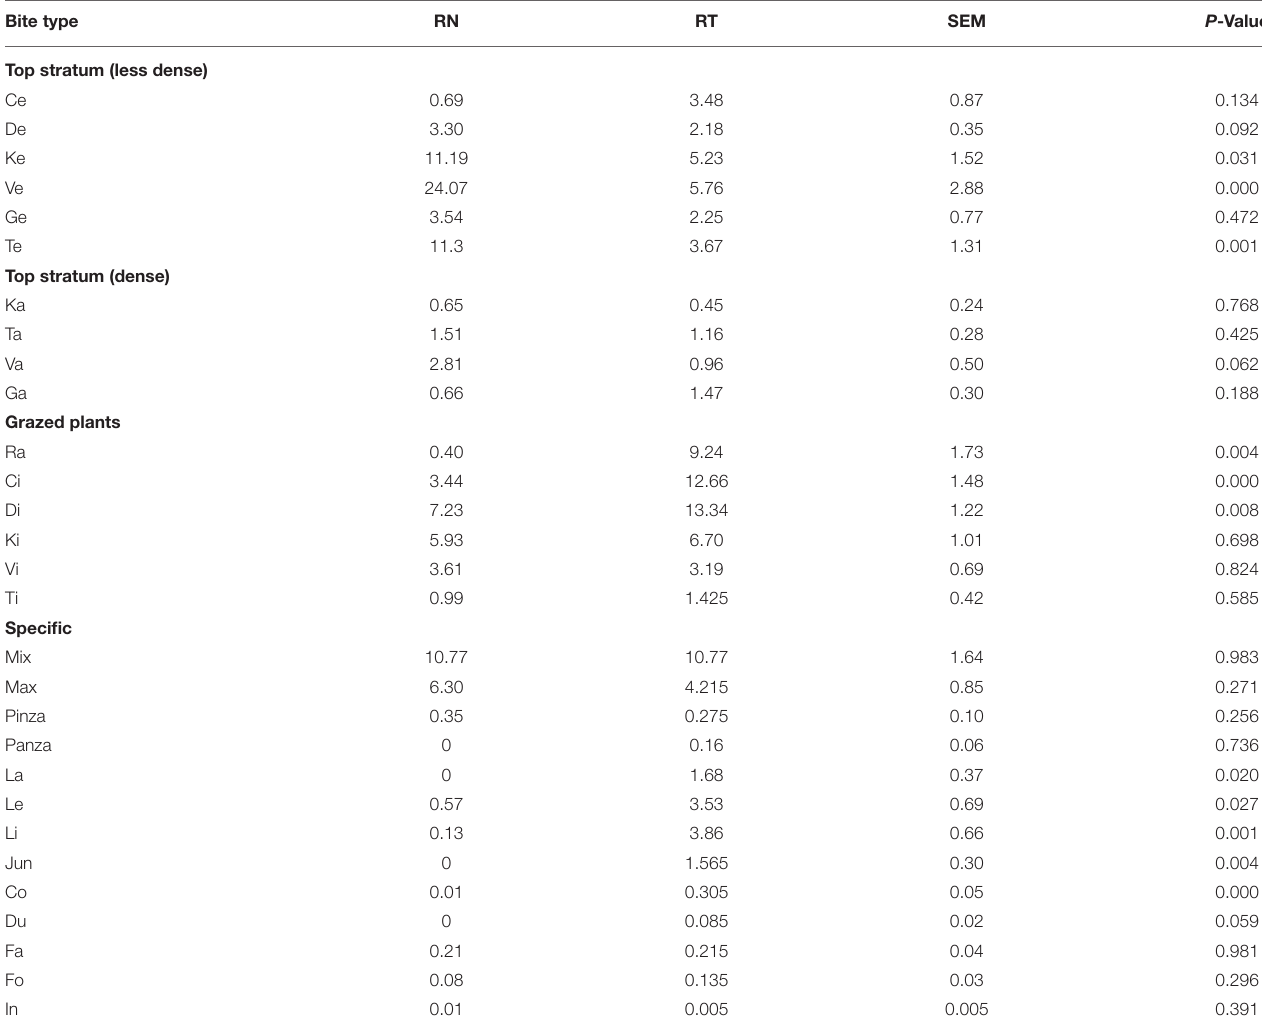
TABLE 2 | Bite-scale characterization of the diet ingested by sheep (relative proportion that each bite type accounted to the diet ingested) grazing vegetative Italian ryegrass pastures under contrasting grazing management strategies (RN and RT) in rotational stocking. Bite